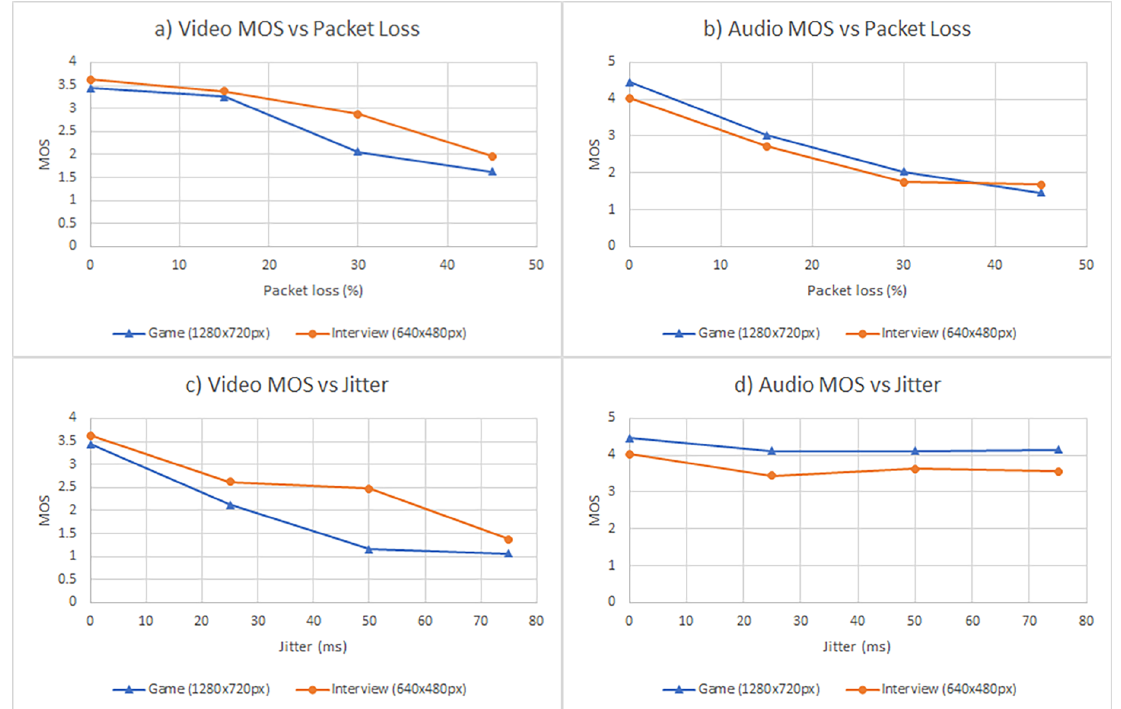
Figure 9. Subjective results in the general availability survey for both sequences (interview and game). ( a ) Video quality results using different scenarios of packet loss. ( b ) Audio quality results using different scenarios of packet loss. ( c ) Video quality results using different scenarios of jitter. ( d ) Audio quality results using different scenarios of